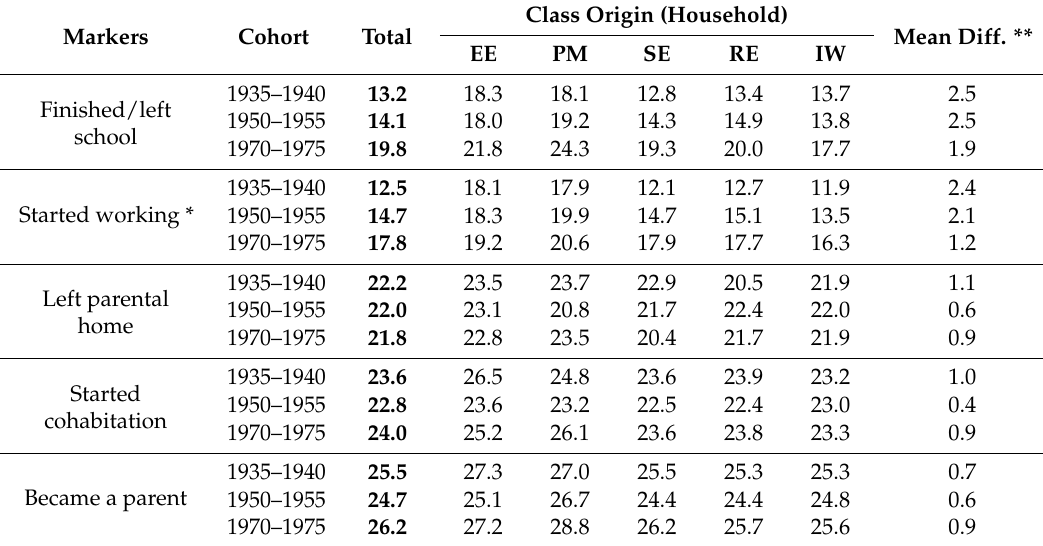
Table 4. Transitions—means per class origin